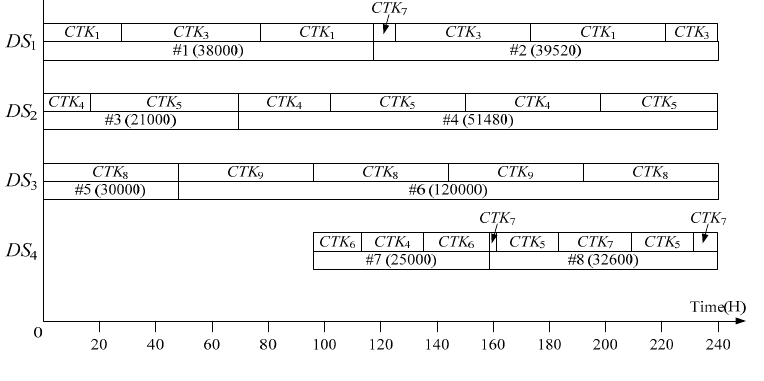
Figure 12. Detailed schedule of distiller feeding.